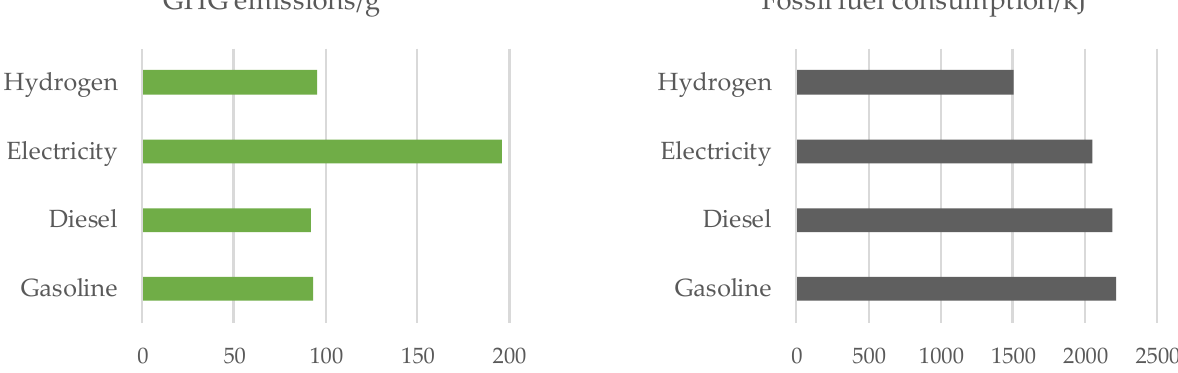
Figure 1. GHG emission and fossil fuel consumption comparison from the fuel-based WTW analysis.